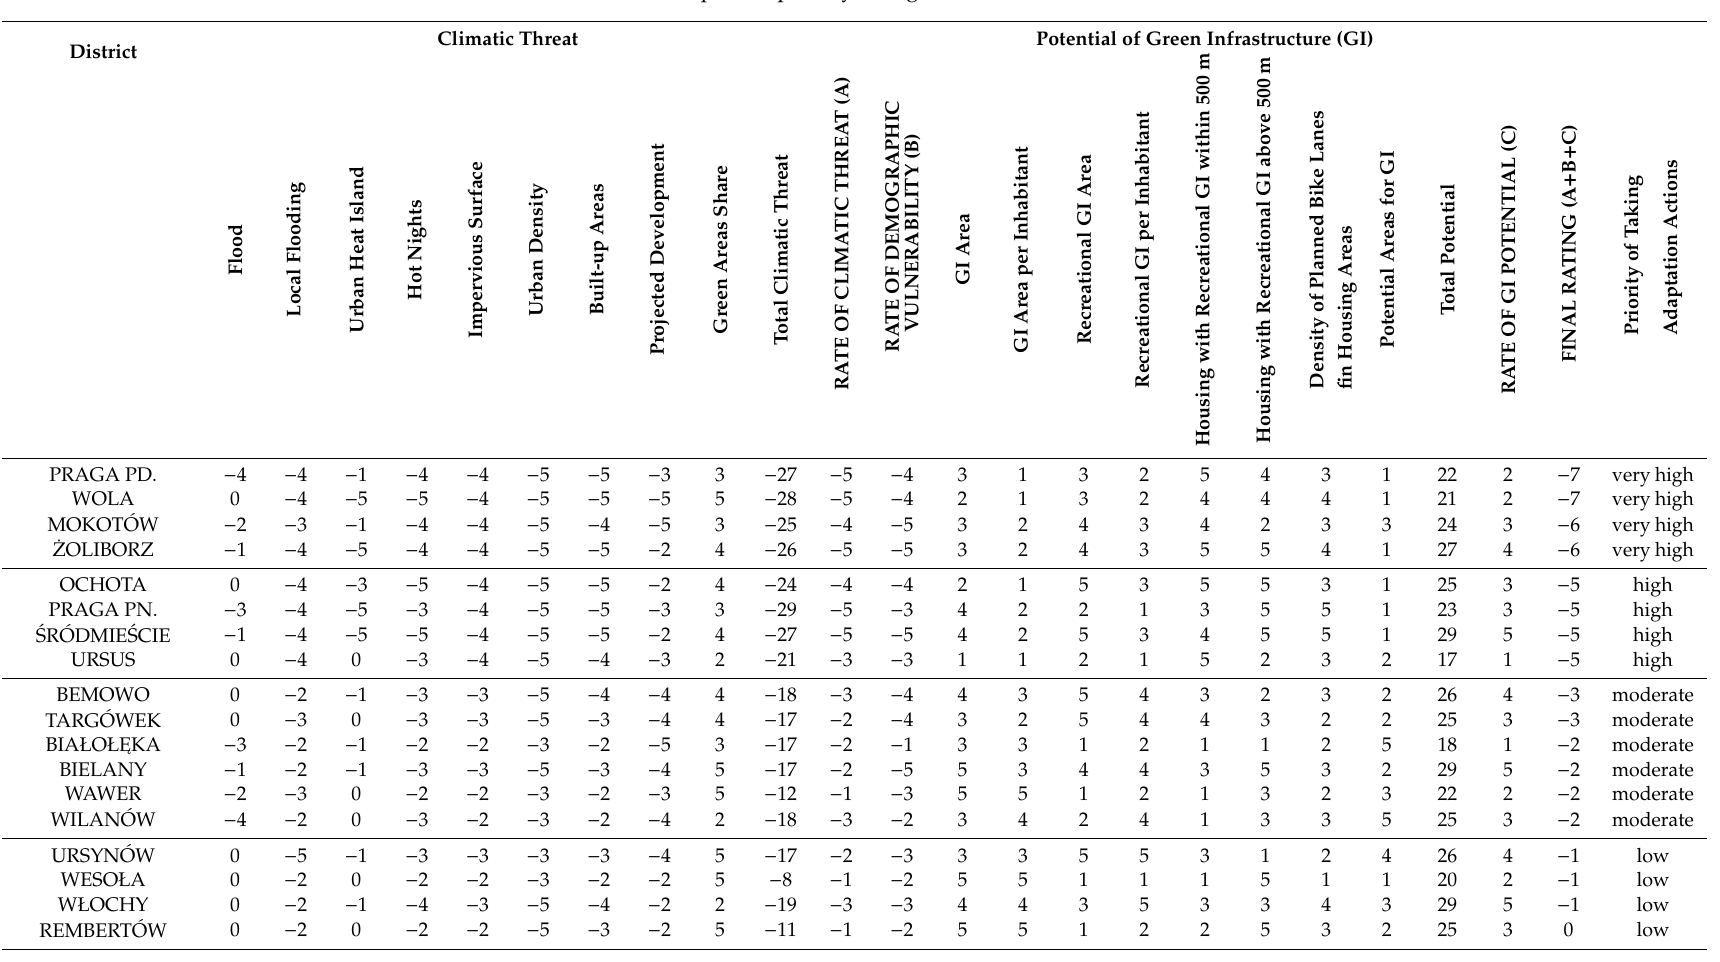
Table 3. Adaptation priority rating of Warsaw’s